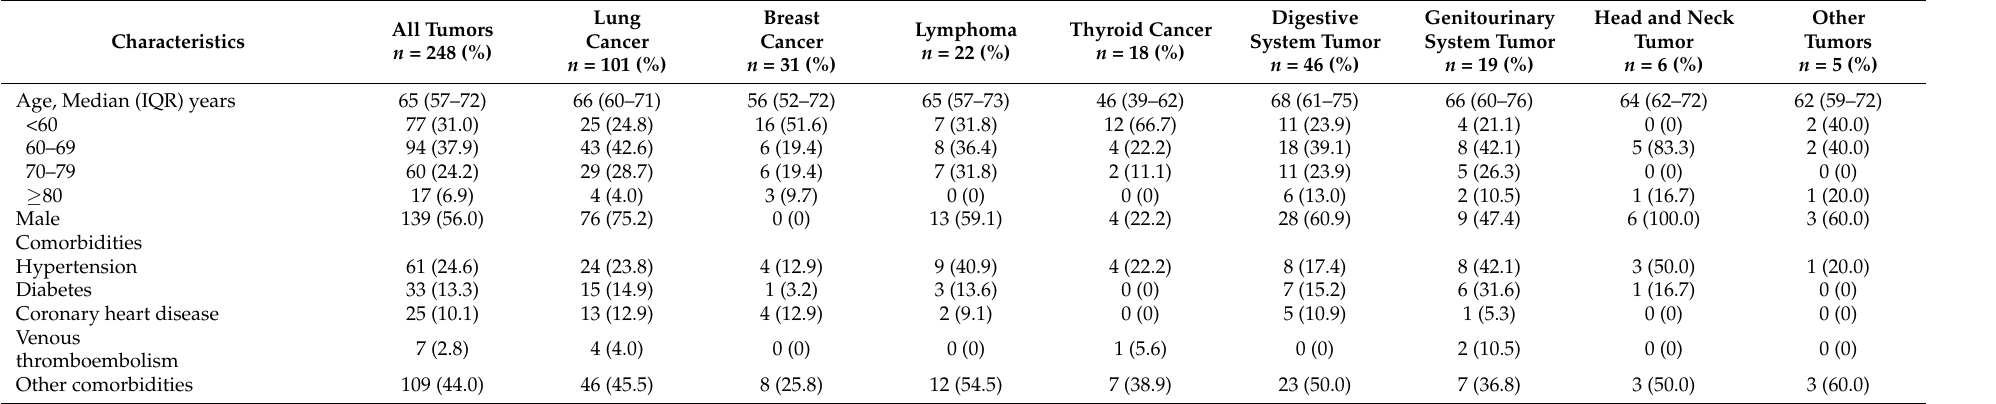
Table 7. Demographic characteristics of patients with ILD-developed